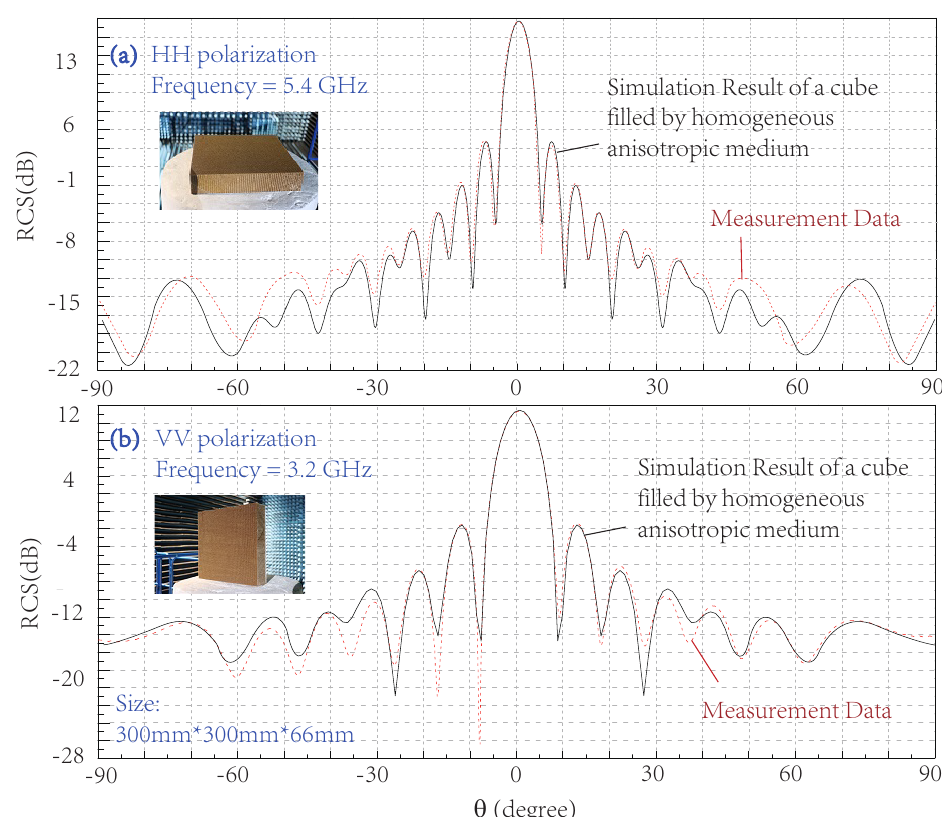
Figure 7. The RCS values of a cuboid-shaped aramid material measured by an experiment which is compared to the full-wave simulation results of a cuboid object occupied by homogeneous anisotropic medium with ( a ) HH polarization at f = 5.4 GHz; and ( b ) VV polarization at f = 3.2 GHz,